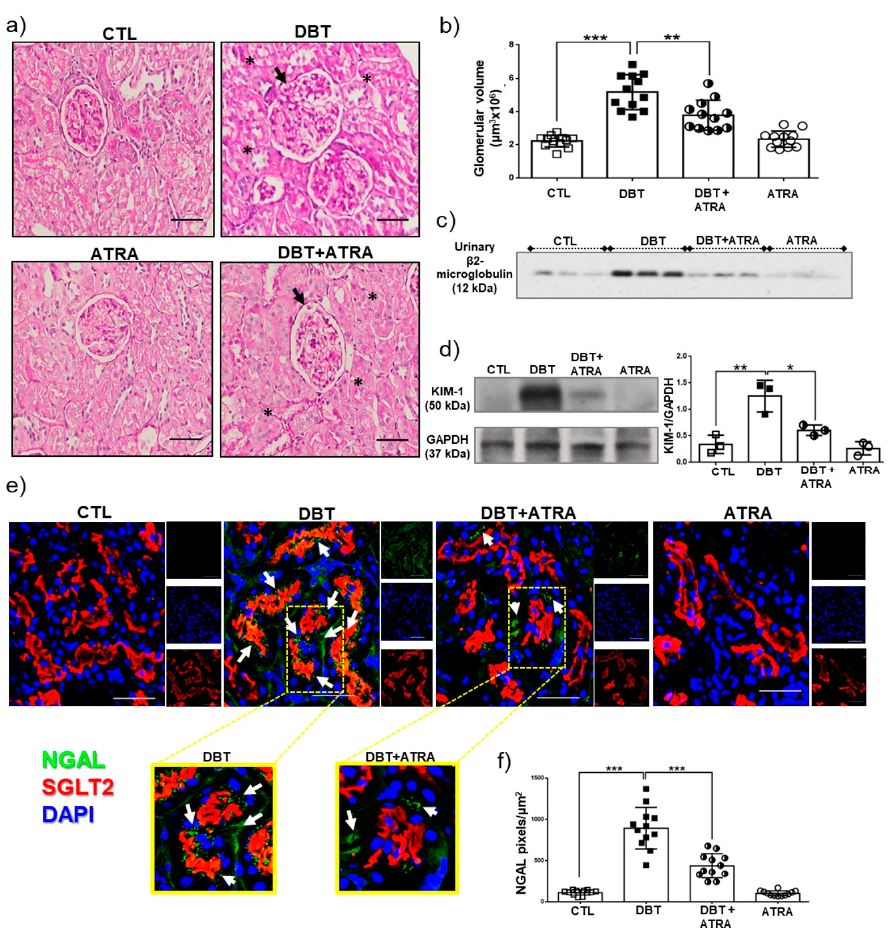
Figure 2. All-trans retinoic acid (ATRA) prevented increment of early markers in diabetic nephropathy. ( a ) Representative histological images of hematoxilin and eosin (H&E) staining of kidney sections from experimental animals, ( b ) glomerular volume analysis, ( c ) Western blot of urinary β 2-microglobulin excretion (equal volume of urine was added from each animal), ( d ) Western blot of KIM-1 and its densitometric analysis in isolated proximal tubules, ( e ) Confocal immunofluorescence of neutrophil gelatinase-associated lipocalin (NGAL, green label), that co- localized with sodium-glucose cotransporter 2 (SGLT2), a marker of proximal tubule brush border (red label). Nuclei were counterstained with 4 ′ ,6-diamidino-2-phenylindole (DAPI, blue label), ( f ) Image-based computer assisted analysis was performed to estimate the amount of NGAL in proximal tubule sections. ATRA administration reversed morphological changes induced by streptozotocin (STZ) in rats after three weeks of hyperglycemia, including glomerular hypertrophy (black arrows), tubular lumen dilation (black asterisks), and increased expression of β 2-microglobulin, KIM-1, and NGAL. Data are shown as mean ± SD (n = 12 glomeruli or proximal tubule sections per group). Glyceraldehyde 3 phosphate dehydrogenase (GAPDH) was used as loading control. Data are representative of three independent experiments, and values are expressed in mean ± SD. * p < 0.05, ** p < 0.01, *** p < 0.001. The scale bar is equal to 50 µ